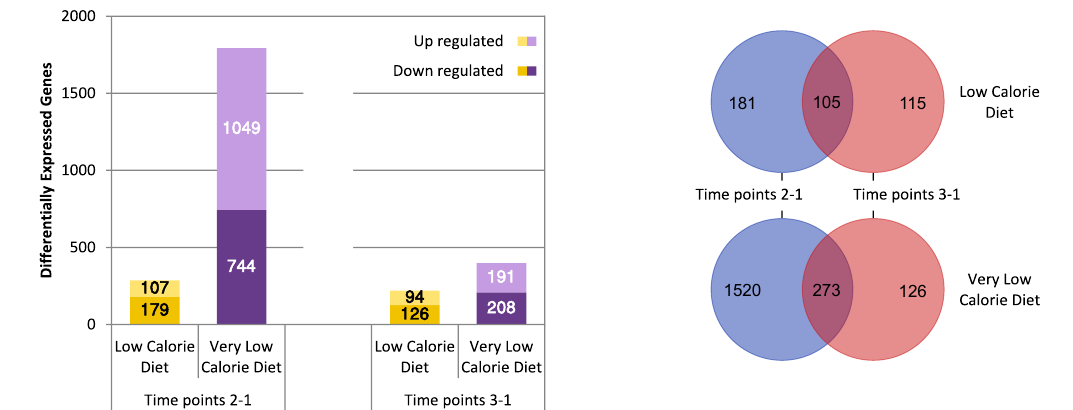
Figure 2. The number of differentially expressed genes in each diet. ( A ) The number of up and downregulated genes along the two time point comparisons. Time points 2-1: After Weight Loss—Before Weight Loss, and time points 3-1: After Weight Maintenance—Before Weight Loss; ( B ) the number of differentially expressed genes overlapping between the two comparisons within each